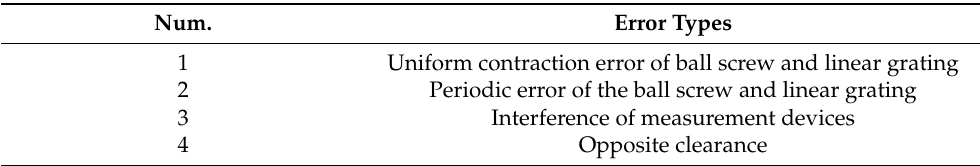
Table 1. The positioning errors of CNC machine tool.